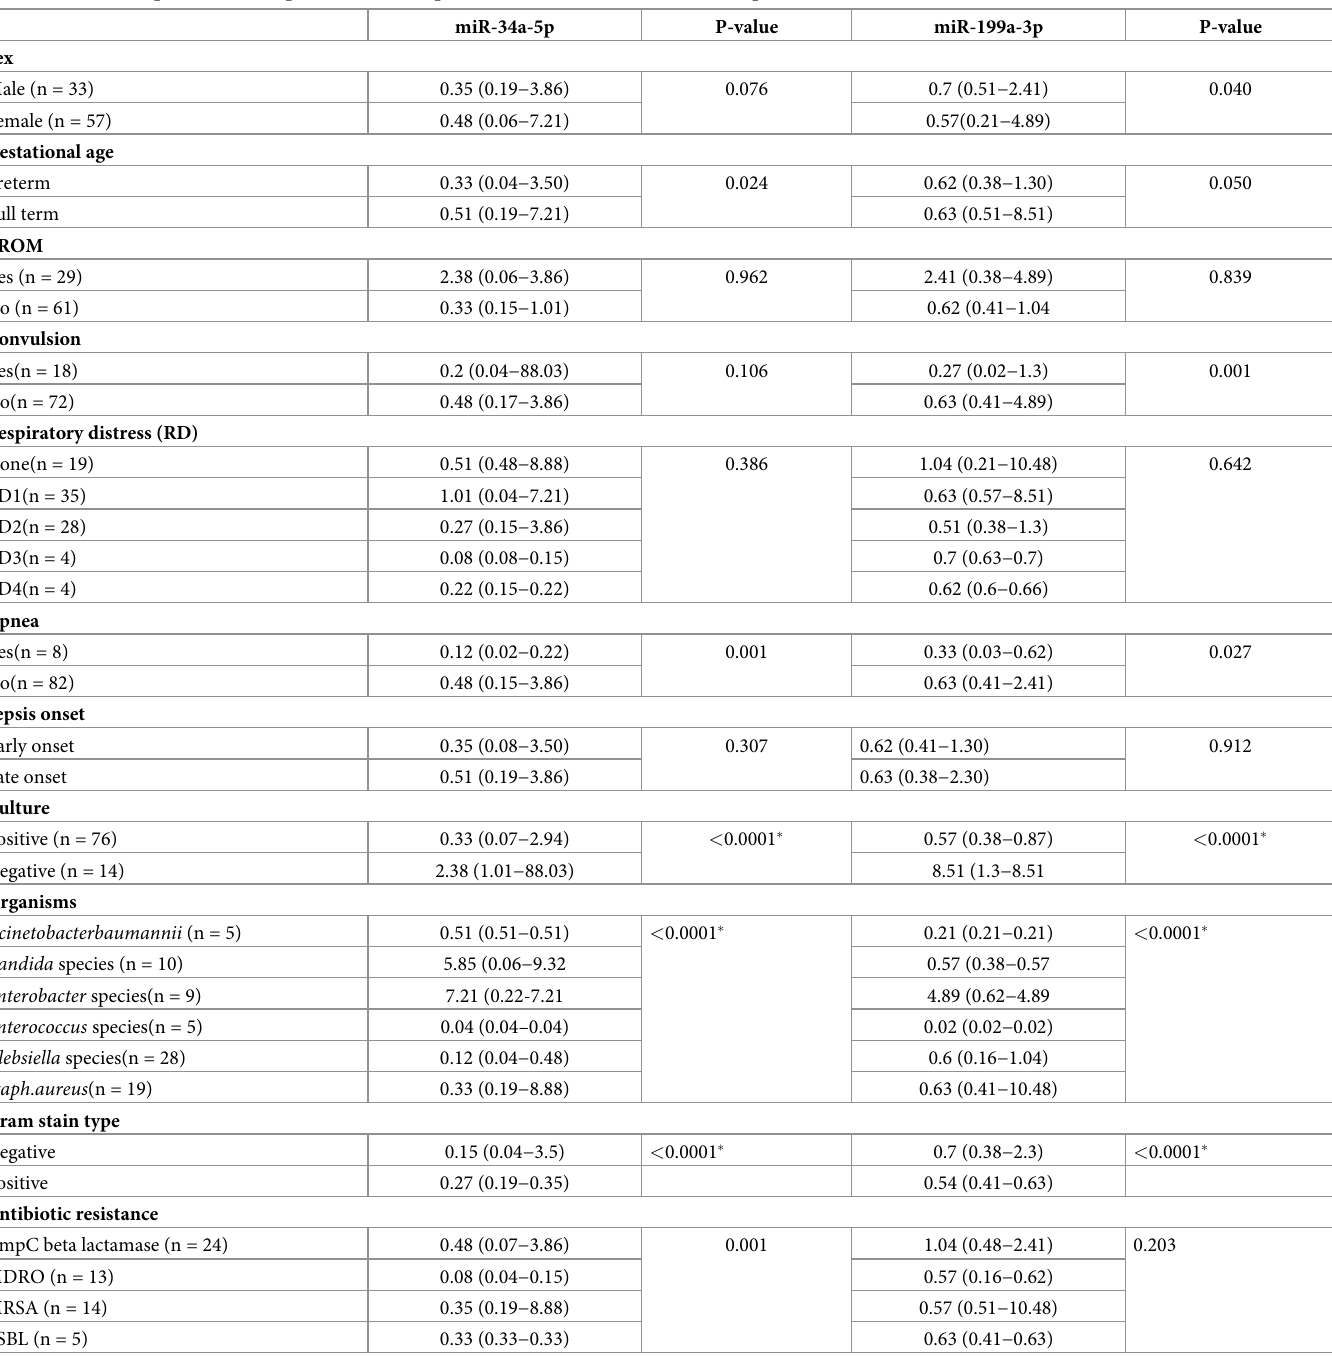
Table 3. Relationships of miR-34a-5p and miR-199a-3p with clinical data in neonates with